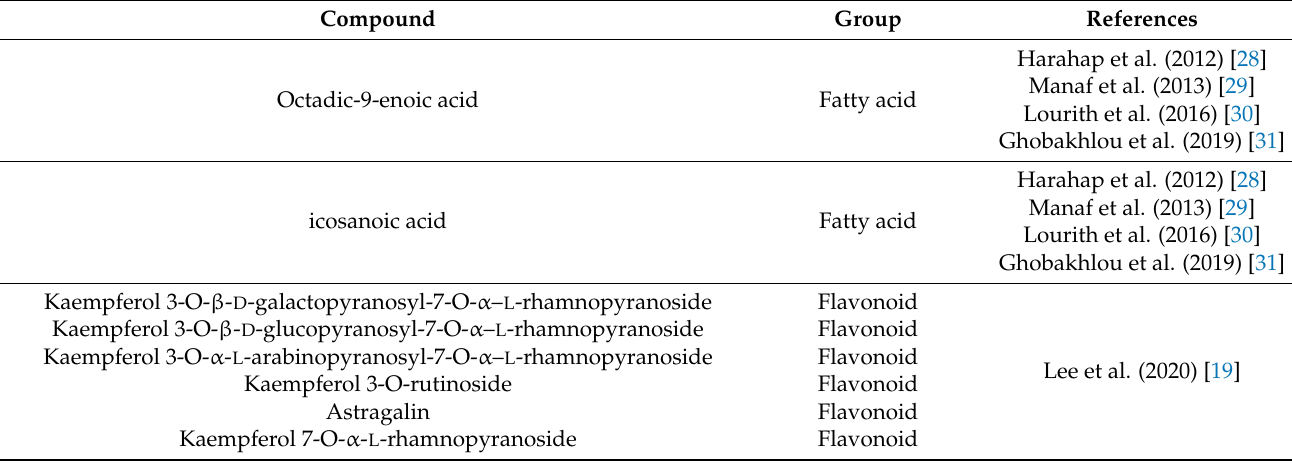
Table 2. Chemical compounds from N. lappaceum seeds.